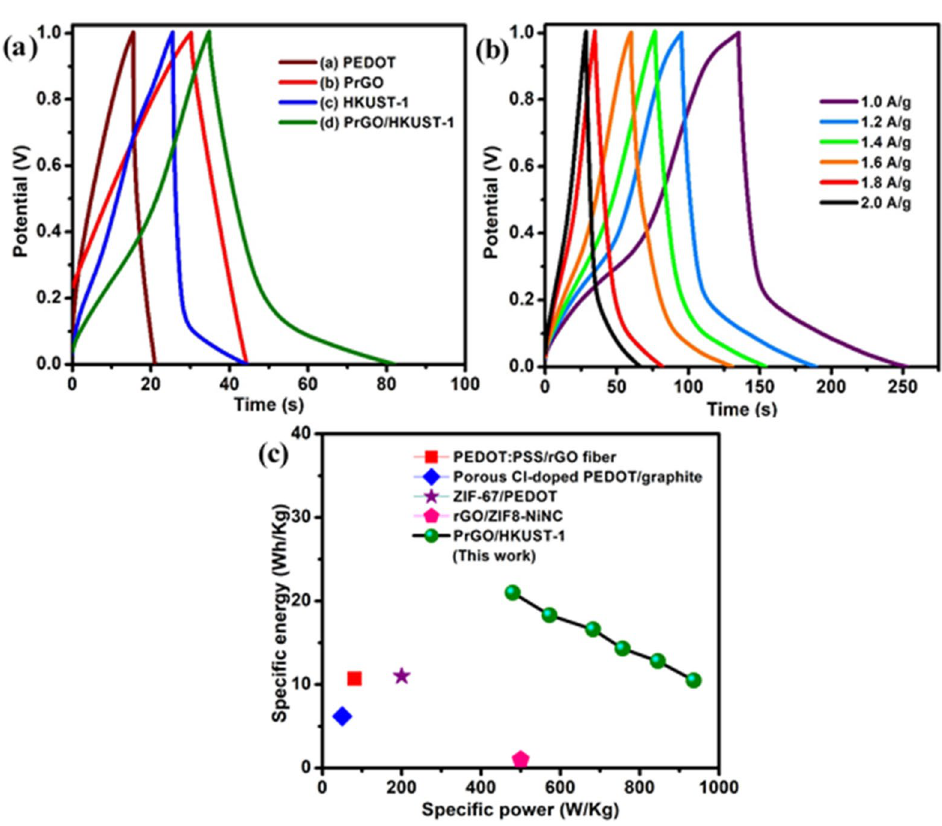
Figure 6. ( a ) GCD analysis of PEDOT, PrGO, HKUST-1 and PrGO/HKUST-1 at a current density of 1.8 A/g using KCl/PVA gel electrolyte, ( b ) GCD analysis of symmetrical PrGO/HKUST-1 at various current densities (1.0–2.0 A/g), ( c ) Ragone plots of